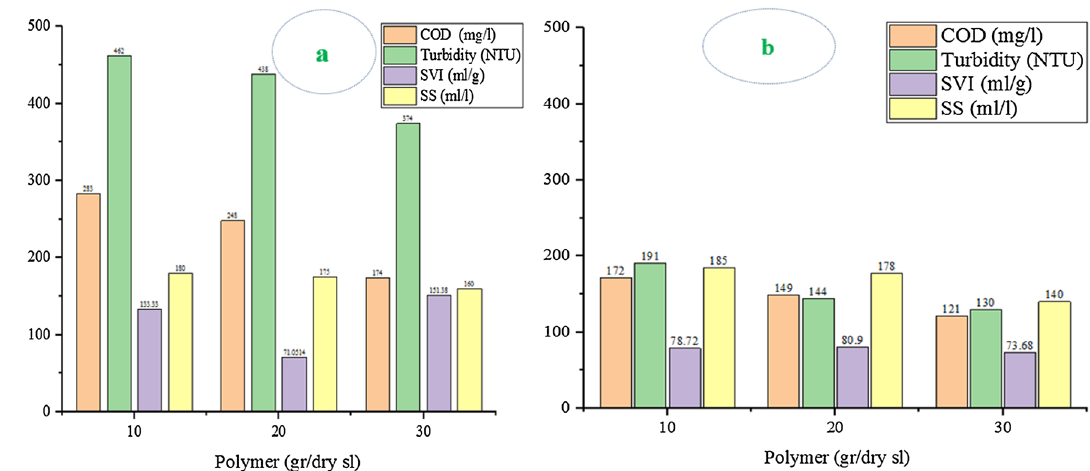
Fig. 1 The effect of polymer concentration on COD, turbidity, SVI, and SS ( b non-ozonation a ozonation (15 min)) (coagulation = 30 s, floccula- tion = 10 min and precipitation = 30